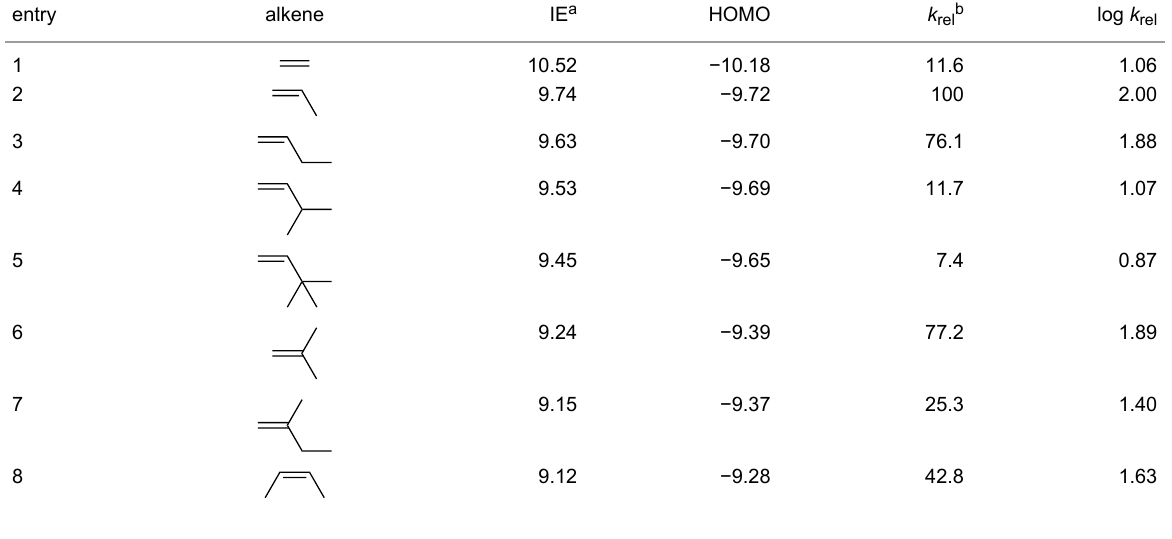
Table 1: Representative alkene IEs (eV), HOMO energies (eV), relative rates ( k rel ), and log k rel values of PhSeCl additions at 25 °C.